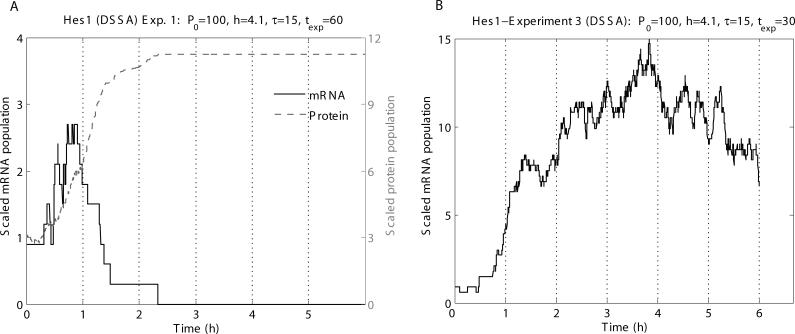
DSSA Simulation(A) Mimicking blocking of Hes1 protein degradation by a proteasome inhibitor.(B) Mimicking inhibition of translation by cycloheximide treatment.